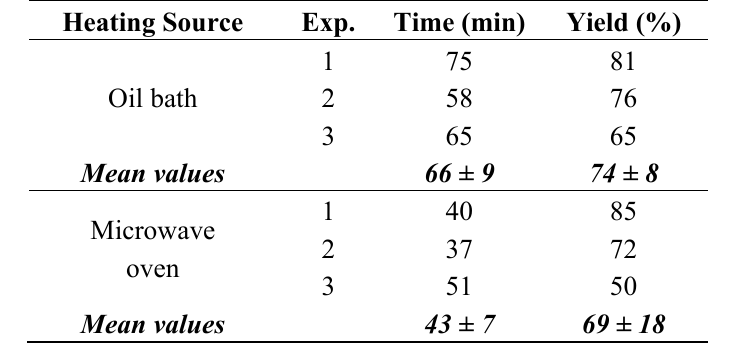
Table 2. Results of BCA indirect synthesis (depolymerization